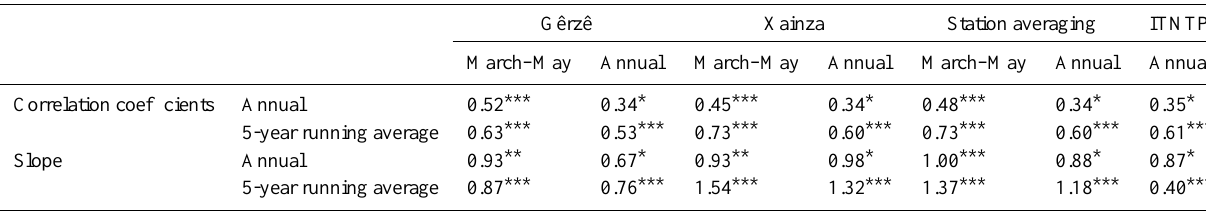
Table 1. Correlation coefficients and linear slopes between the δ 18 O values in the ZK ice core and instrumental spring (March–May) and annual temperature from closest stations, Gêrzê (1973–2008) and Xainza stations (1961–2008); the averaged records of the two stations (1961–2008); and the ITNTP series (1961–2008).